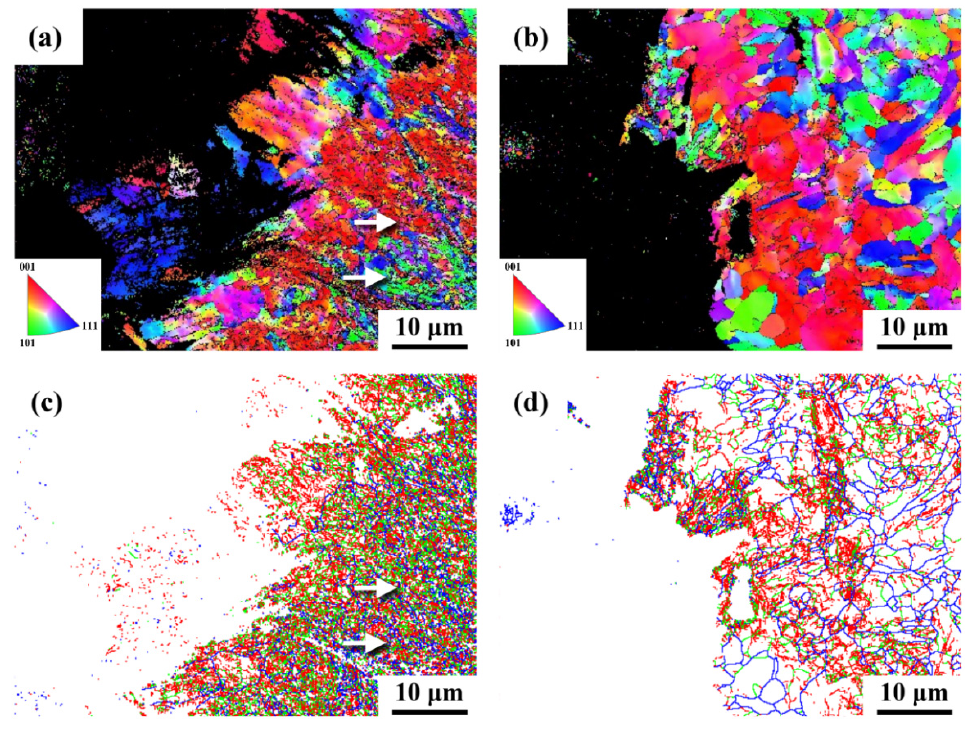
Figure 10. ( a , b ) The inverse pole figures, ( c , d ) grain boundary maps of the fracture zone for the ( a , c ) WP-800P specimen and ( b , d ) WP-860P specimen tested at 903 K/120 MPa. (